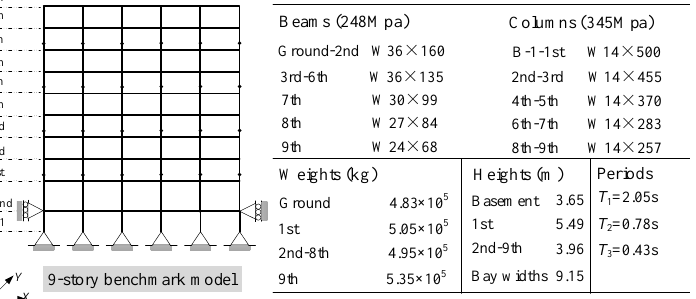
Figure 12. The prototype building.